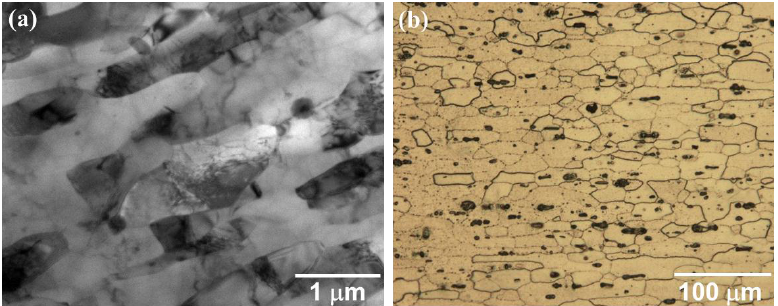
Figure 1. The microstructure of the base metal of ( a ) ultrafine grained (UFGed) 1050 aluminum and ( b ) 6061-T6 aluminum